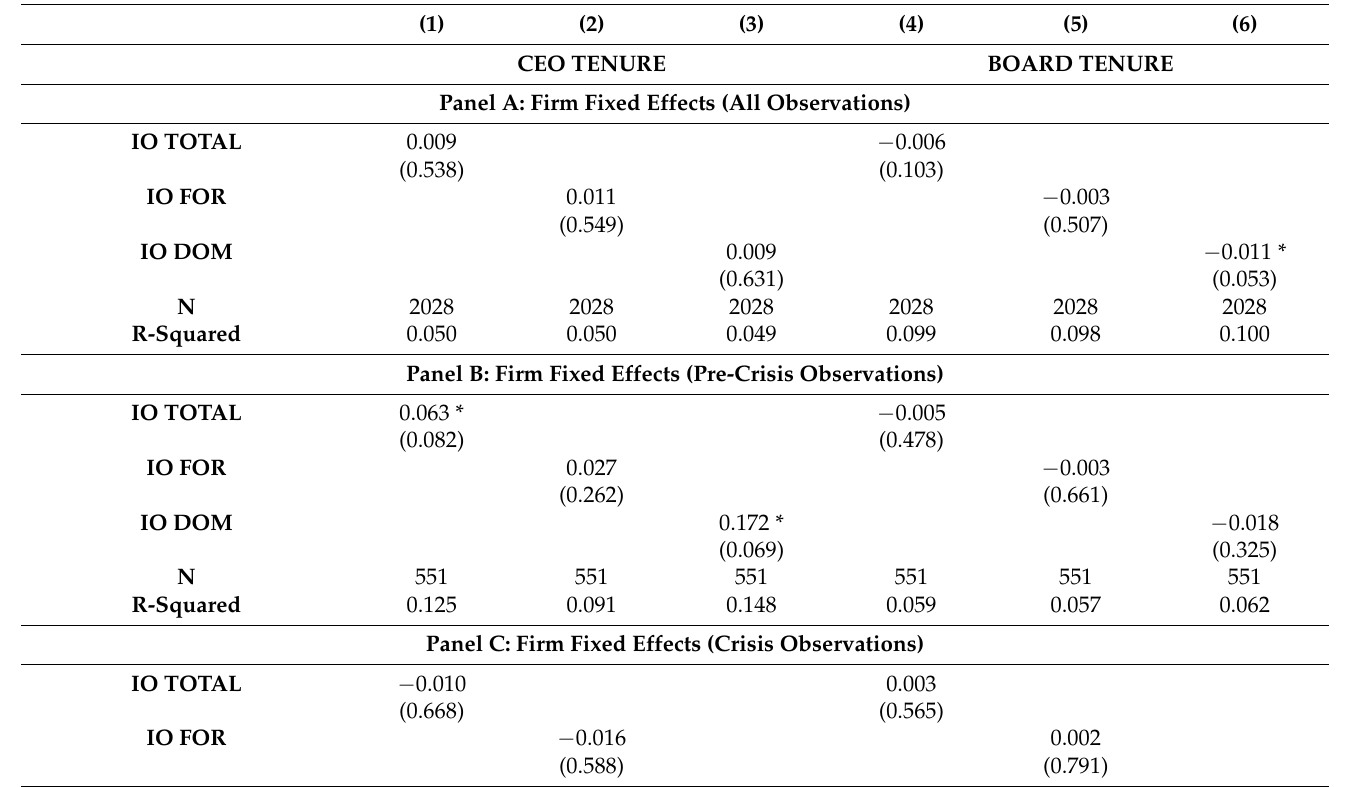
Table 4. Institutional Ownership and Board Entrenchment.